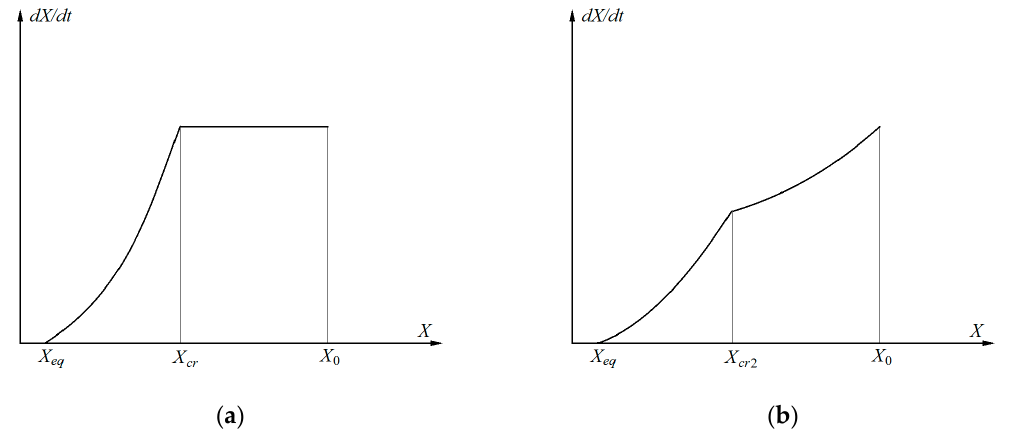
Figure 2. Schematic presentation of the drying rate function: ( a ) Existence of the constant drying period, and ( b ) existence of the two stages of the falling drying rate period.